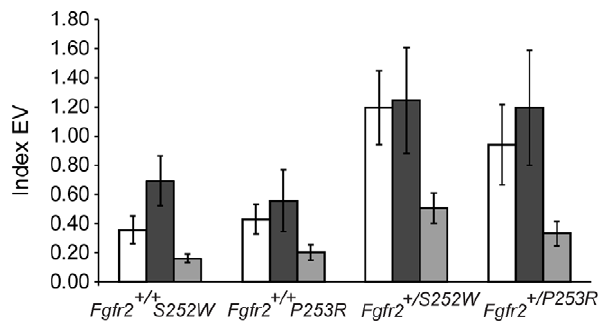
Figure 4. Comparison of MI within and between facial skeleton and neurocranium across Apert syndrome mouse models and non-mutant littermates. Bar graphs with standard deviation error bars comparing the distribution of the integration index (EV, Eigenvalue variance standardized by group variance*10 5 ) within the face (white bars), within the neurocranium (dark grey bars) and between the face and the neurocranium (light grey bars).